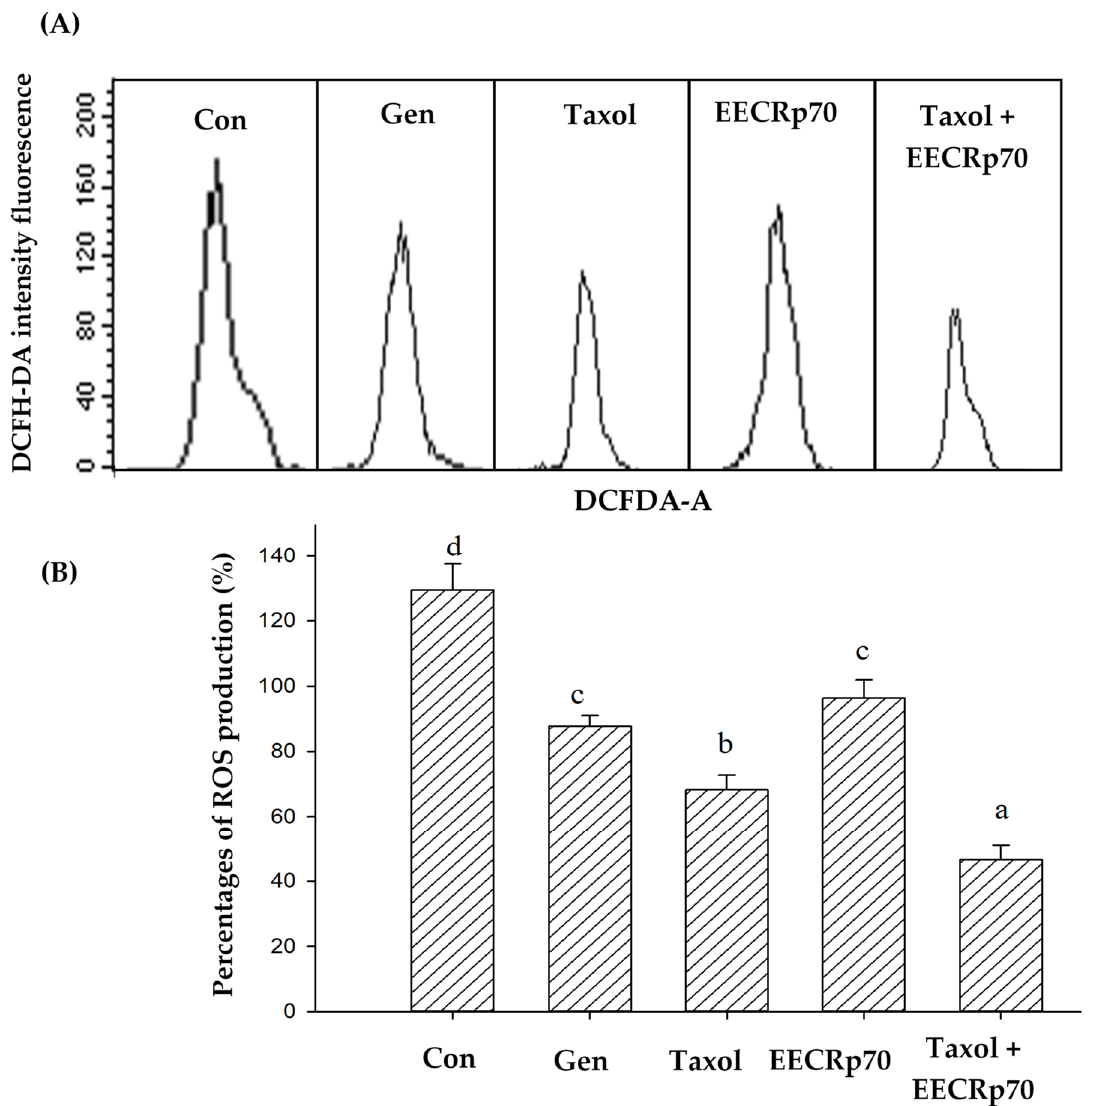
Figure 7. Effect of EECRp70 on ROS production. SCC25 cells treated with 25 µM genistein (Gen), 10 nM taxol (Ta), 25 µg/mL EECRp70 and 10 nM taxol + 25 µg/mL EECRp70 incubated for 24 h. Intracellular levels of ROS were measured by DCF the fluorescence intensity using a flow cytometer. ( A ) Cells were collected and incubated with 30 µM DCFH-DA at 37 °C for 1 h in the dark, washed with PBS × 1, and analyzed by flow cytometry. ( B ) Quantitative analysis of the percentage of ROS production in the cells. Values (mean ± SD) that do not have the same letter are significantly different ( p < 0.05).